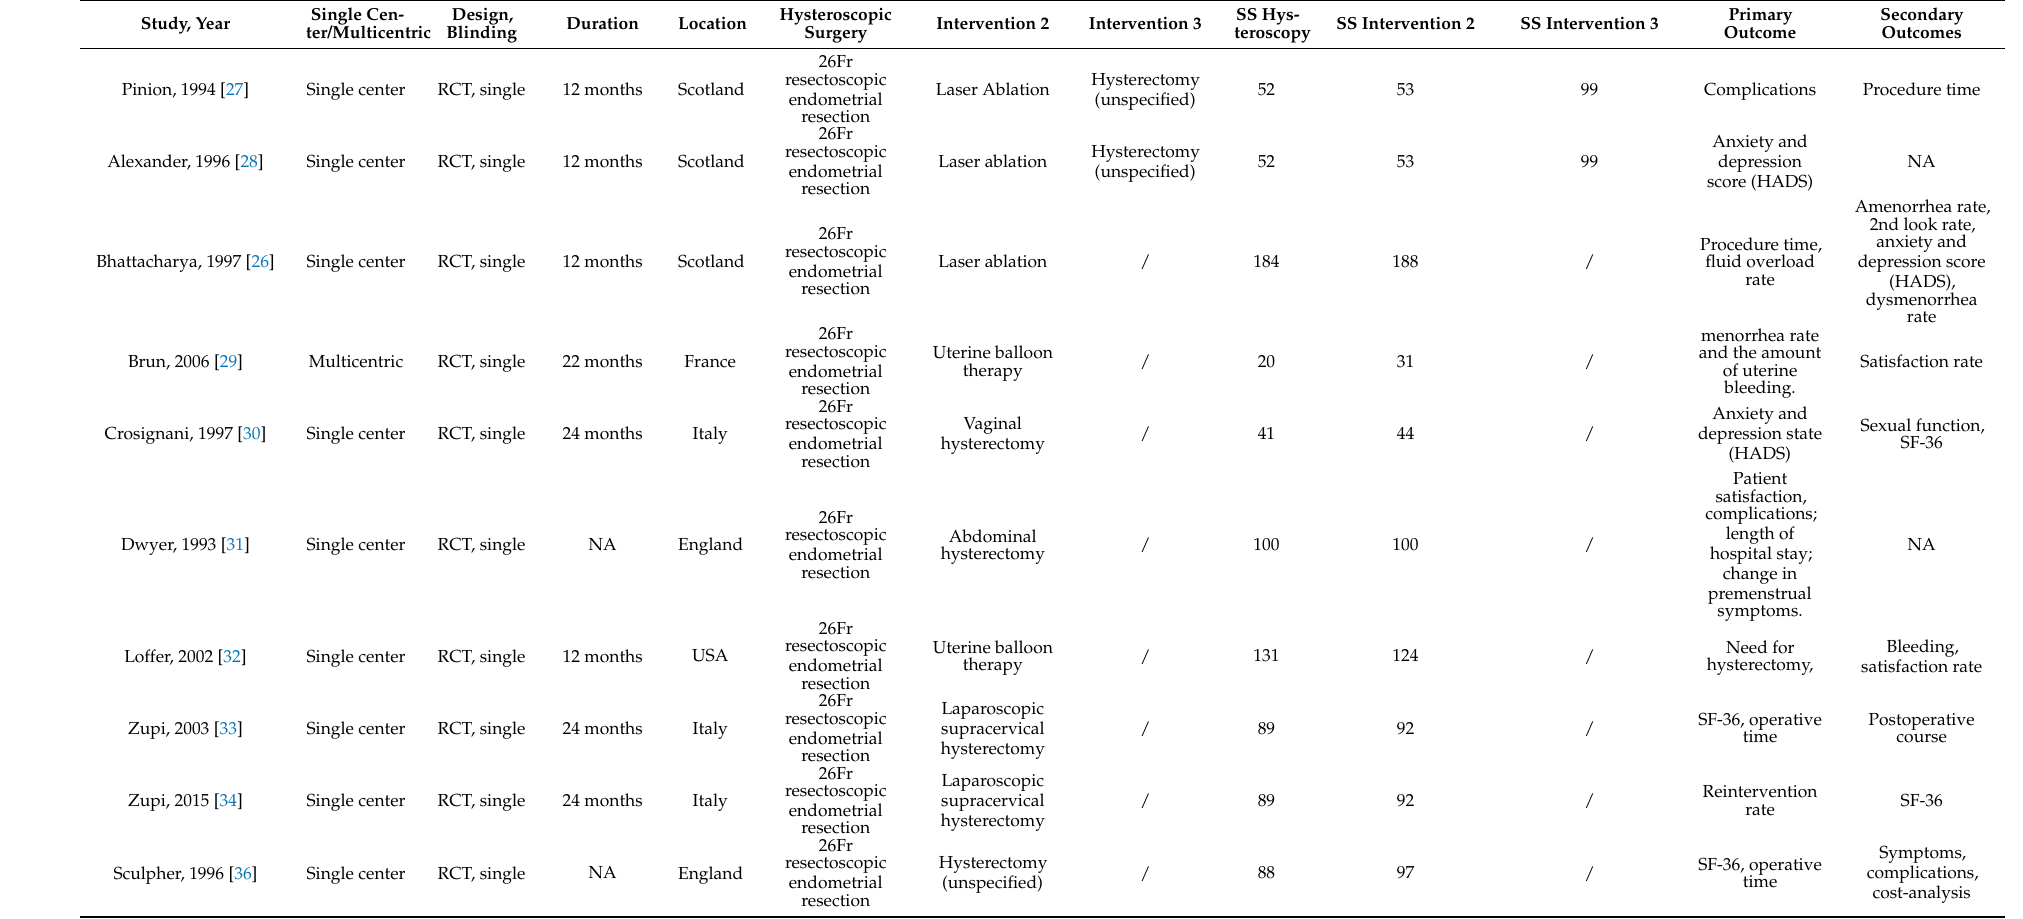
Table 1. Main characteristic of studies included in quantitative synthesis and